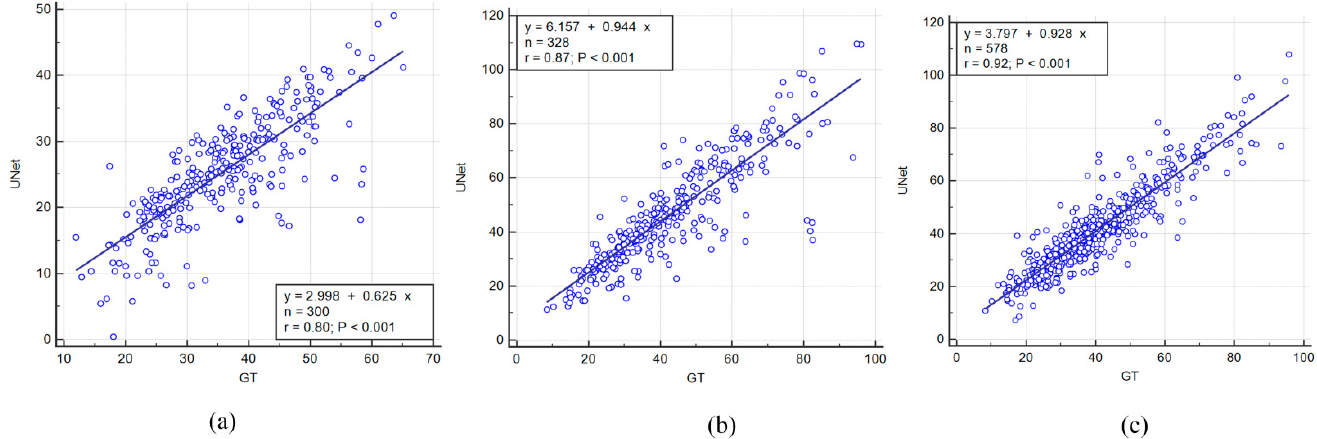
Figure 6. Regression plots for Unseen AI and Seen AI experiments. ( a ) Experiment #1 (Unseen AI-1 (Tr: JAP, Te: HK)) ( b ) experiment #2 (Unseen AI-2 (Tr: HK, Te: JAP)) ( c ) experiment #3 (Seen AI-1 CV w/ Mixed).